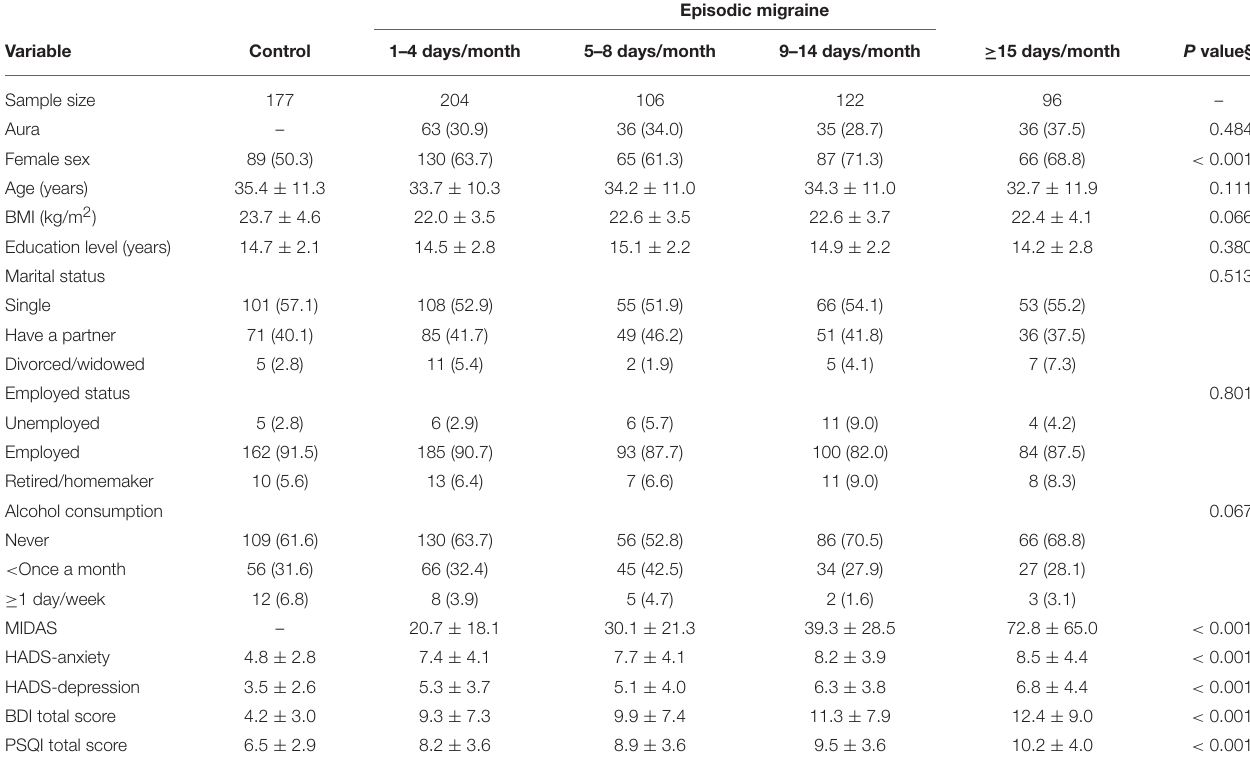
TABLE 1 | Characteristics of the study population.